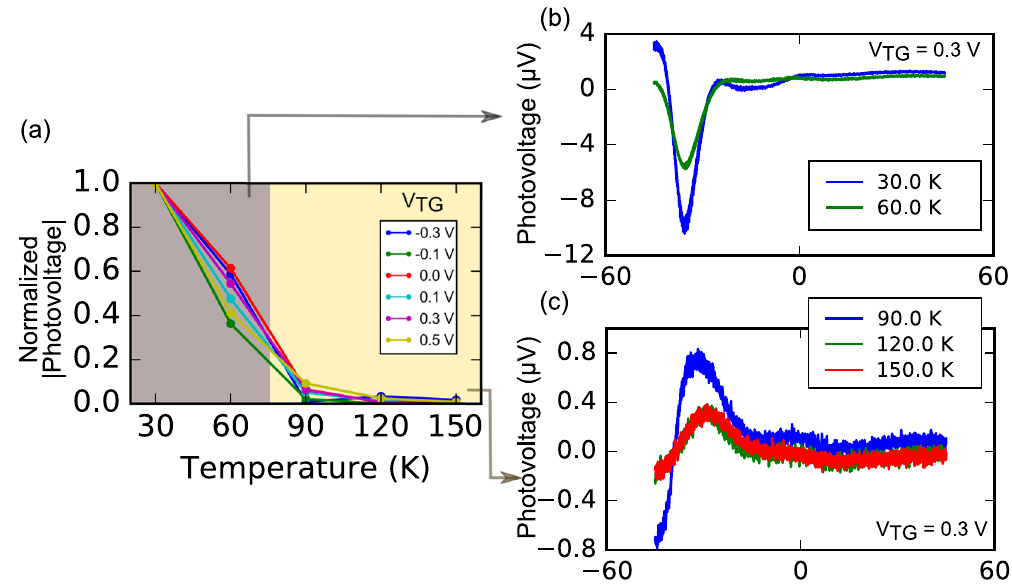
Figure 6. Temperature dependence of the photovoltage. (a) Normalized photovoltage magnitude as a function of temperature at different top gate voltages when n BG = − n TG . The normalization factor depends on V TG . (b) and (c) The photovoltage as a function of the back gate at V TG = 0.3